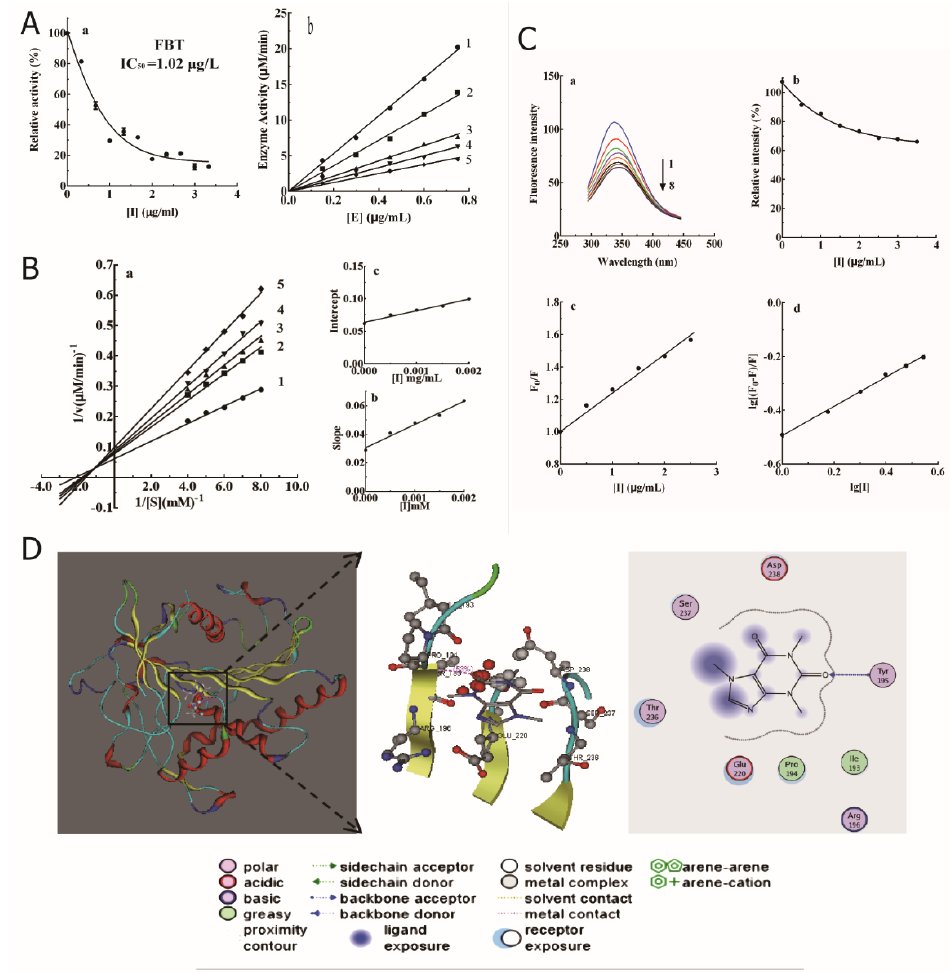
Table 1. Inhibition constants of FBT on lipase.